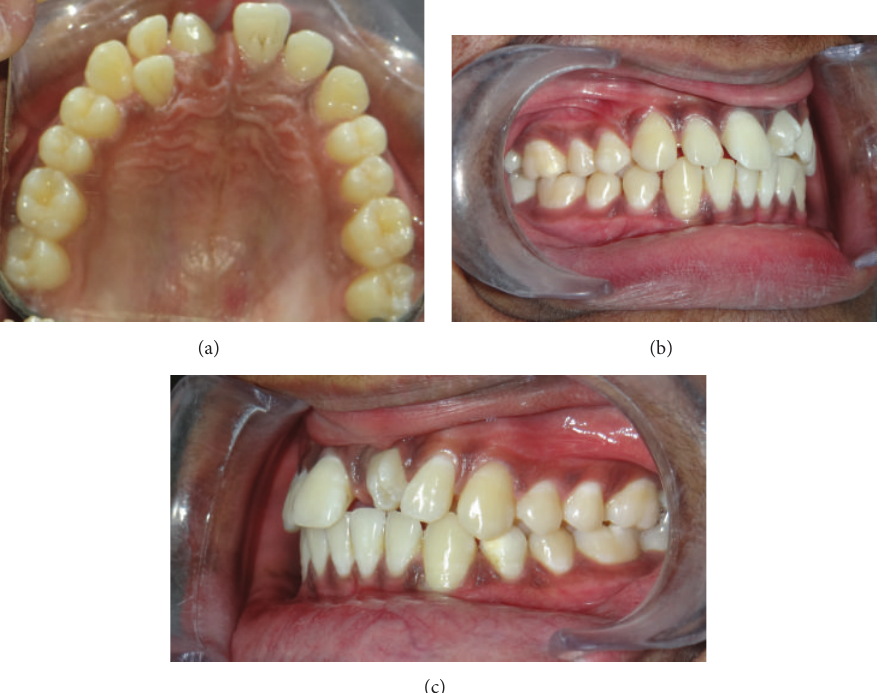
Figure 2: Clinical photographs of erupted dilated odontoma: (a) occlusal view, (b) right lateral view, and (c) left lateral